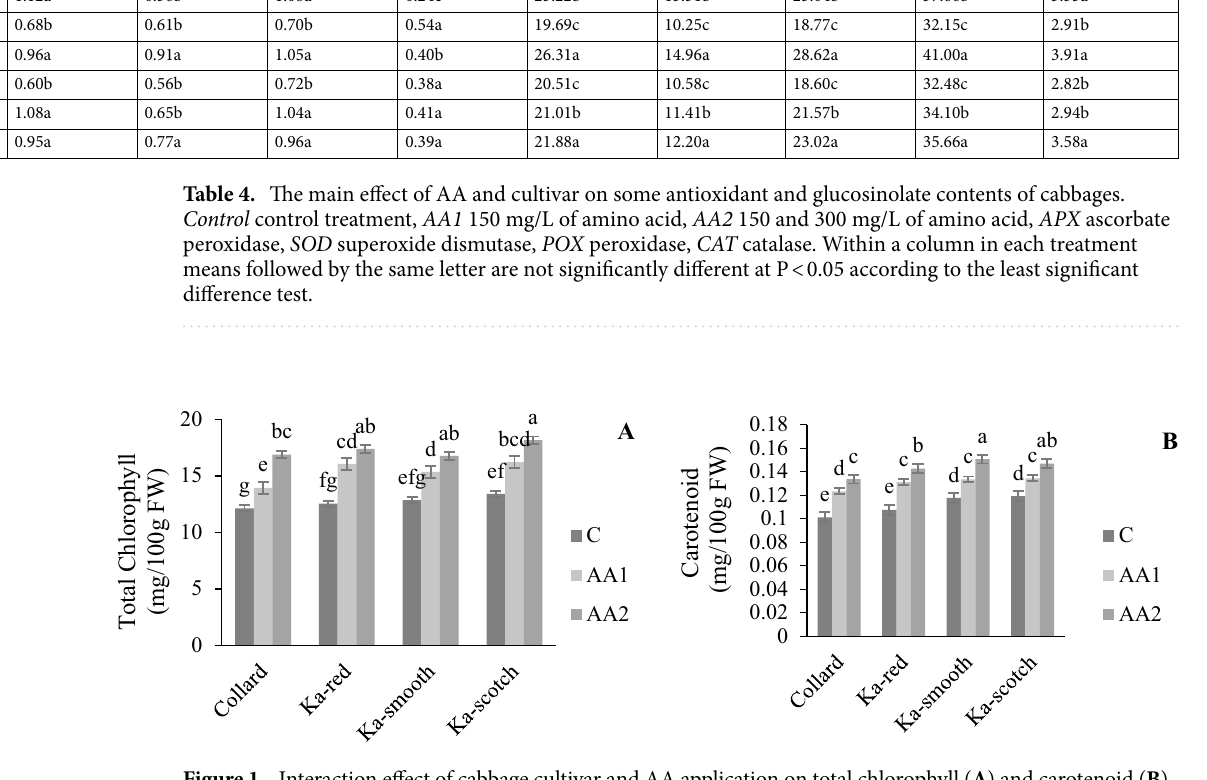
Figure 1. Interaction effect of cabbage cultivar and AA application on total chlorophyll ( A ) and carotenoid ( B ). C control treatment, AA1 150 mg/L of amino acid, AA2 150 and 300 mg/L of amino